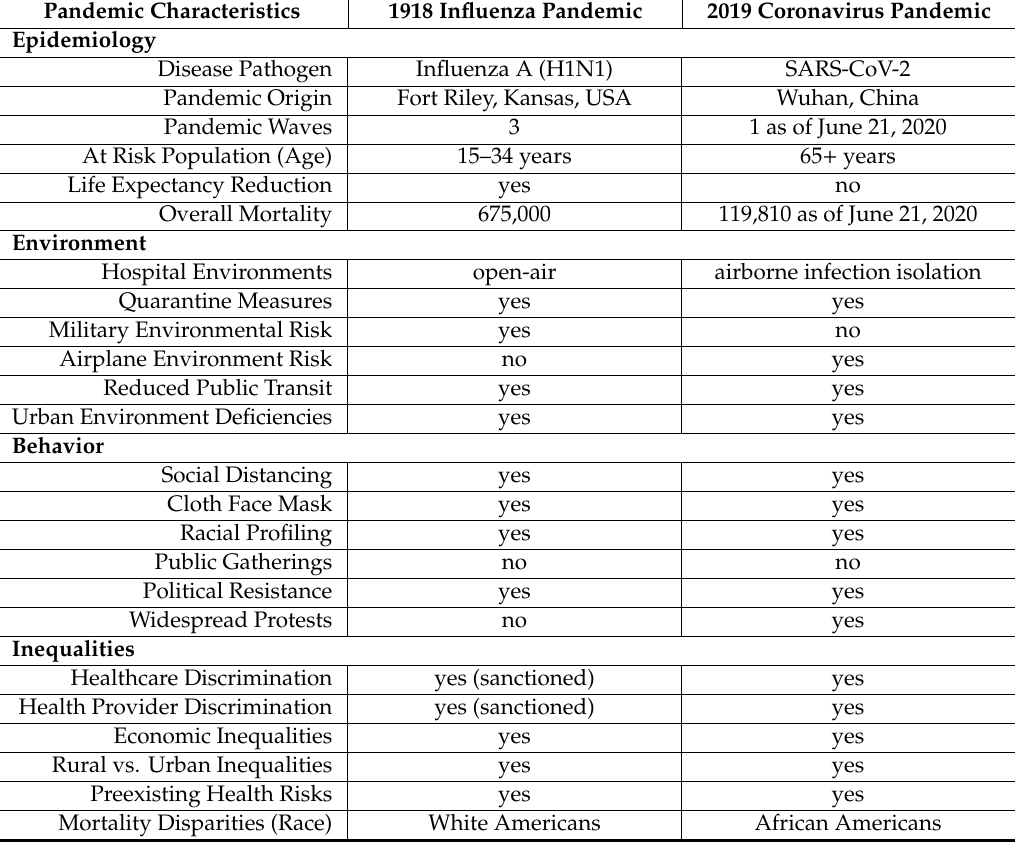
Table 2. Comparison of the 1918 and 2019 pandemics in the United